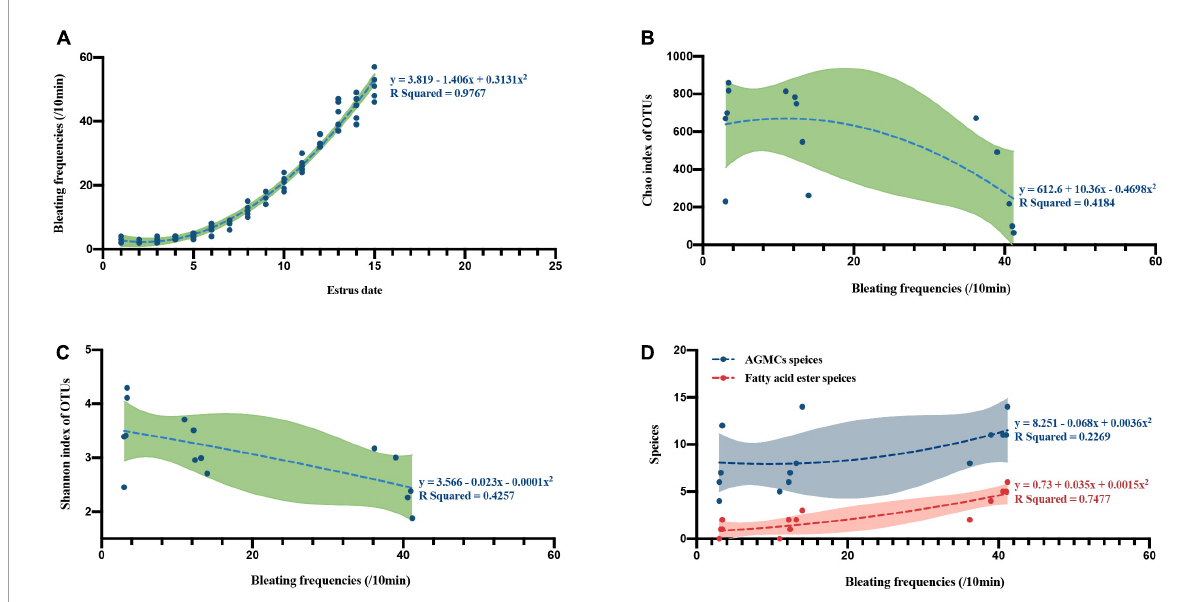
FIGURE5 The curve fit and correlation between bleating frequencies and different estrus phases, microflora richness, microflora diversity and different anogenital gland secretion compounds (AGMCs or fatty acid ester). (A) A curve fit between estrus date and bleating frequencies ( n = 5). (B) A curve fit between bleating frequencies and microflora Chao richness index ( n = 15). (C) A curve fit between bleating frequencies and microflora Shannon diversity index ( n = 15). (D) Curve fit between bleating frequencies and anogenital gland secretion compounds species (blue stands for AGMCs species, red stands for fatty acid ester species, n =